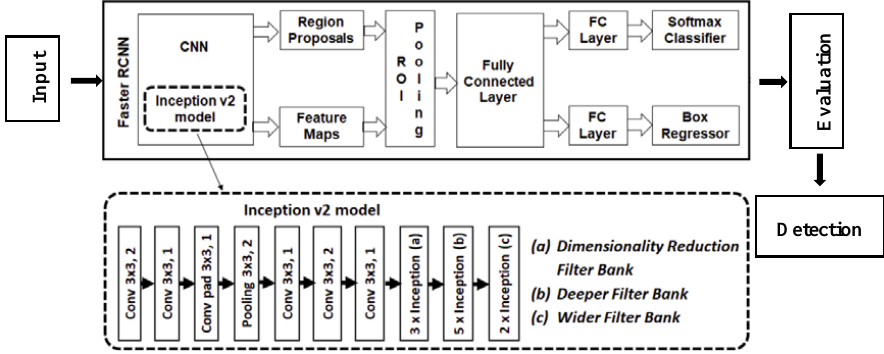
Figure 3. Structure of Faster RNN network with inception V2 model [28].